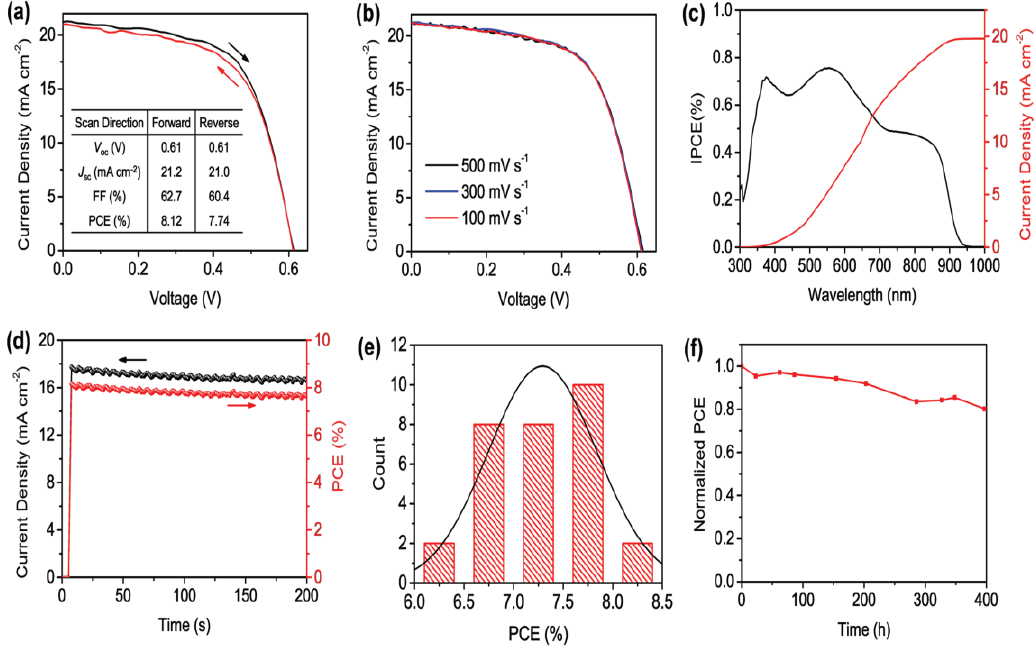
Figure 4. ( a ) J-V curves of the champion device measured using both forward and reverse scan mode at rate of 300 mV/s under the simulation of A.M 1.5 G, 100 mW/cm 2 ; ( b ) J-V curves of the